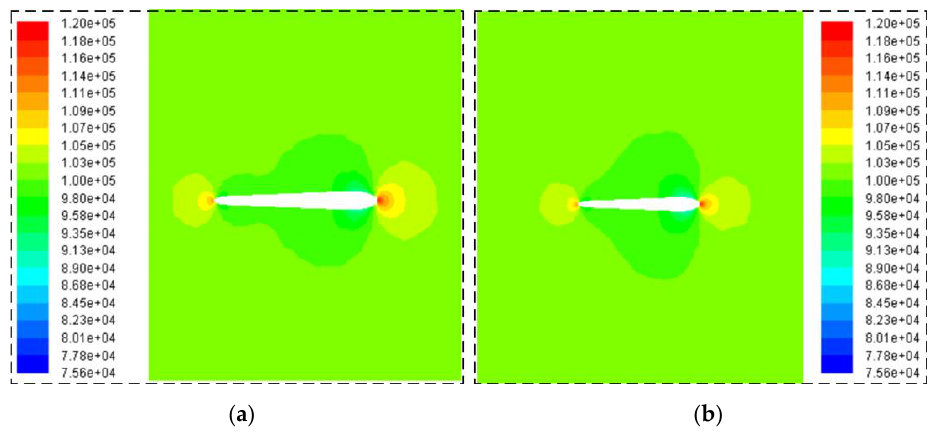
Figure 8. Flow field analysis: X t = 0.1 m; V ∞ = 125.8 m/s; static pressure (Pa); ( a ) Section z = 0.5 m; ( b ) Section z = 2.5 m.